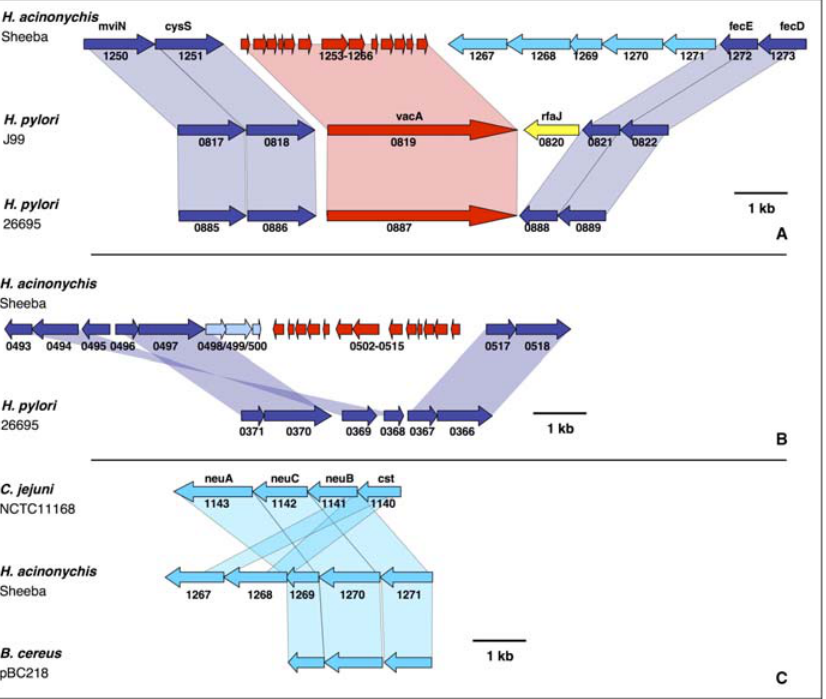
Figure 3. Gene Fragmentation, Duplication, and Import (A) Fragmentation of the vacA (vacuolating cytotoxin) gene (red) into 13 fragments and import of neuACB, cst, cst (blue-green) within Sheeba. neuACB encode acylneuraminate cytidyltransferases and cst encodes a sialyltransferase. (B) Translocation of a duplicate of the fragmented vacA gene to a different genomic location. The duplicated vacA gene (red) contains the same fragmentation pattern and differs by only one sequence polymorphism in 3,815 bp from that in part A, indicating that the duplication is recent and occurred after the fragmentation event. Next to the duplicated vacA gene are located three genes (light blue) that are unique to H. acinonychis . (C) Homologies of the neuACB, cst, cst gene cluster from part A with syntenic clusters in C. jejuni NCTC11168 and the B. cereus virulence plasmid pBC218. DOI: 10.1371/journal.pgen.0020120.g003